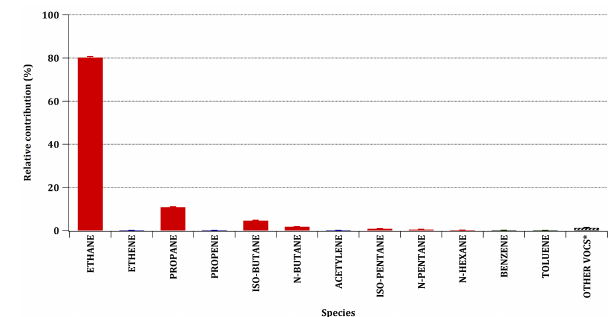
Figure 4. Average chemical composition of natural gas used in Paris. *Other VOCs include heavier alkanes (e.g., cyclopen- tane/hexane, dimethyl butanes) and butenes in lower proportions. Whiskers correspond to error bars (1 σ ).